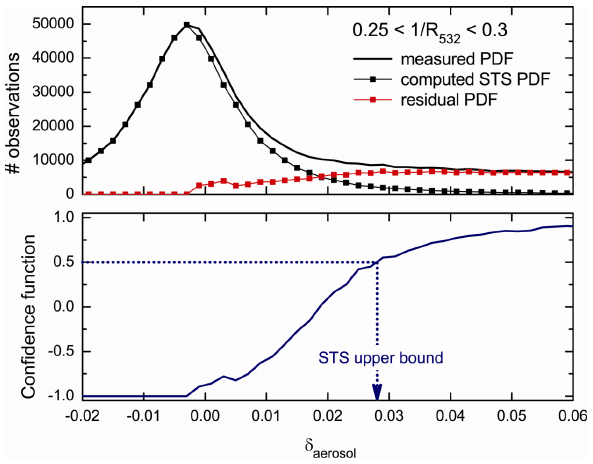
Figure 9. Illustration of procedure used to define the upper bound in aerosol for the STS PSC composition class. Fig. 9. Illustration of procedure used to define the upper bound in δ aerosol for the STS PSC composition class.